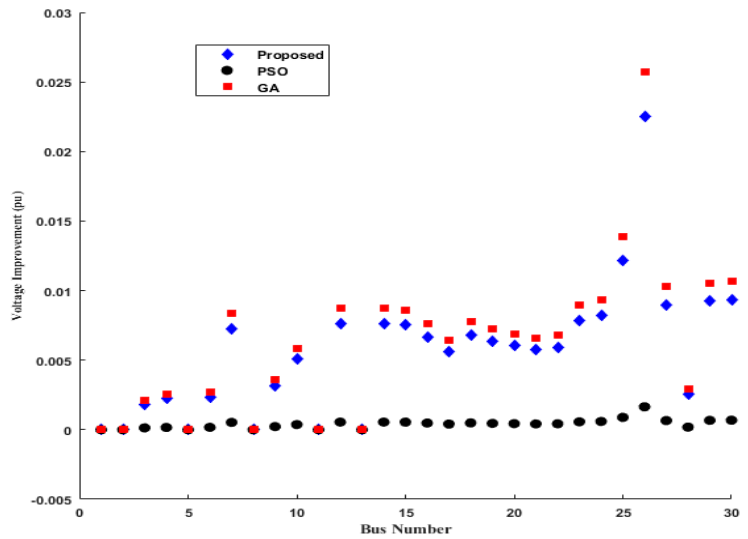
Figure 7. Voltage improvement compared to the overload voltage with no optimization.